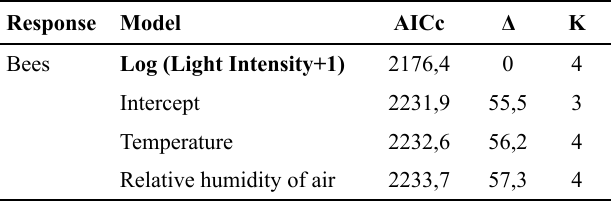
Table 2. Models describing the probability of microclimatic variables that influenced the abundance of visits of the most frequent bees on the flowers of Ipomoea bahiensis . Comparisons of the different models with sample size correction (AICc), AICc differences (Δ), number of variables (k). The models are classified in the ascending order of AICc.